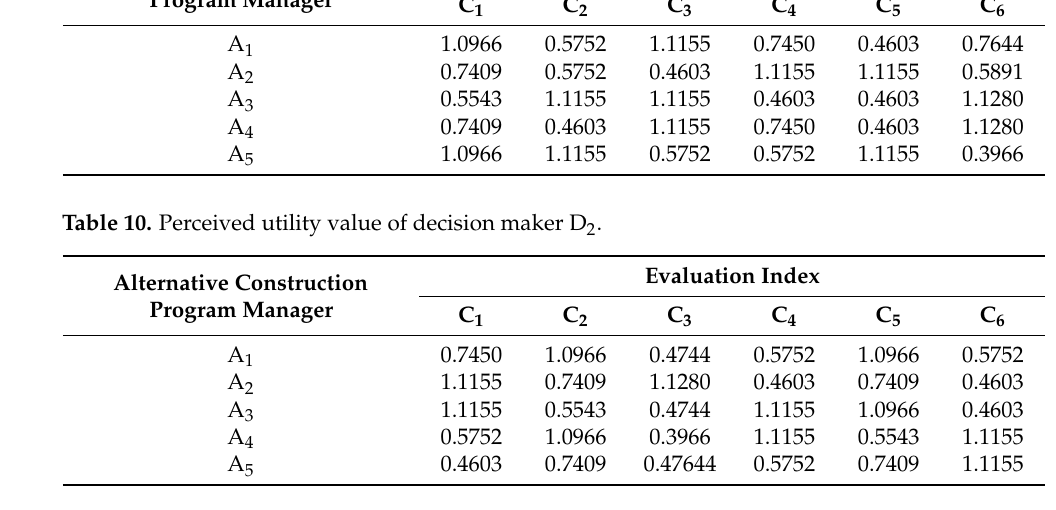
Table 11. Perceived utility value of decision maker D 3